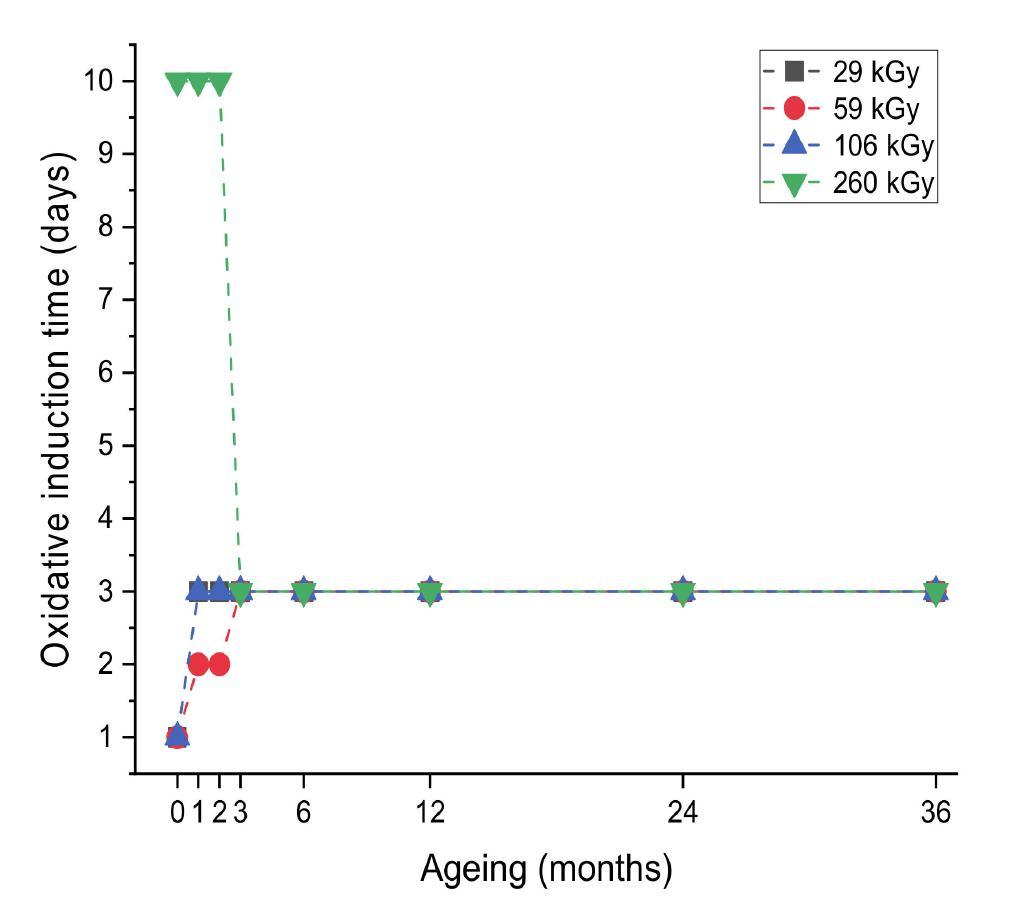
Figure 4. Plots of aging before filling versus induction time for the oxidation of methionine at di ff erent